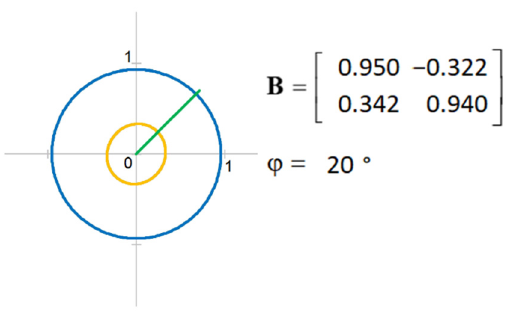
Figure 14. General tensor for rotational matrix with angle ϕ = 20 ◦ .